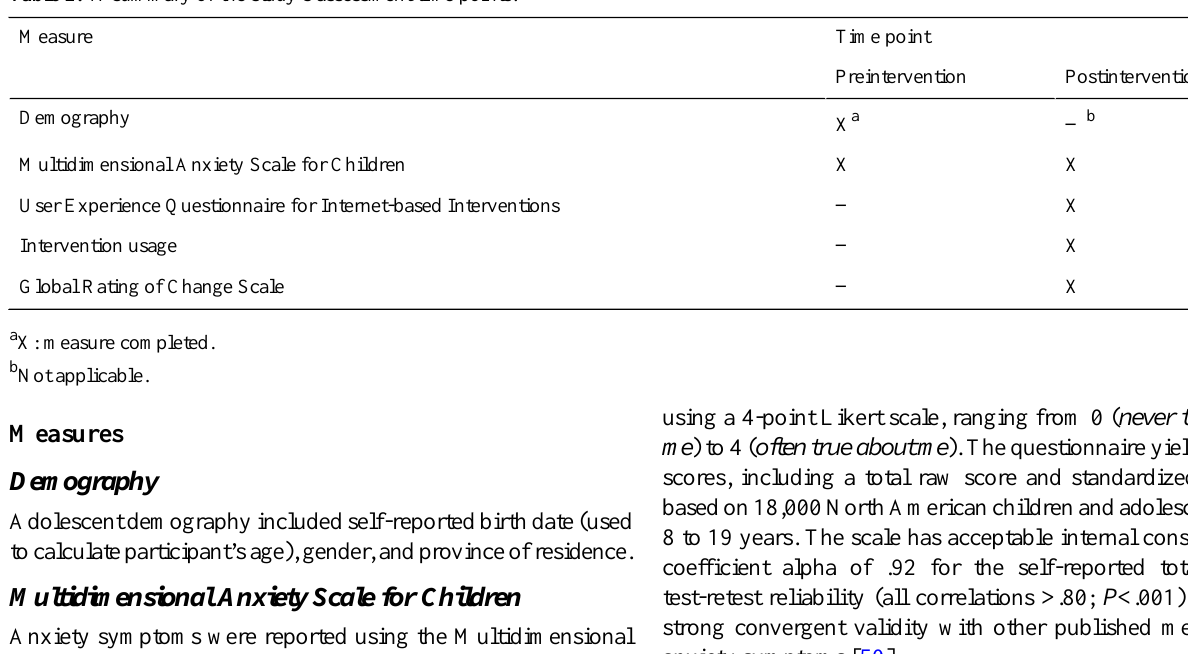
Table 2. A summary of the study’s assessment time